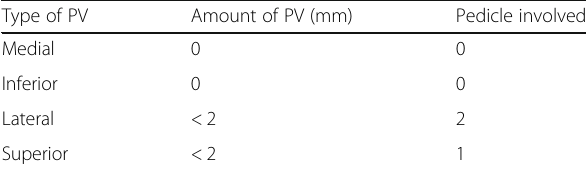
Table 3 Pedicle violation by postoperative